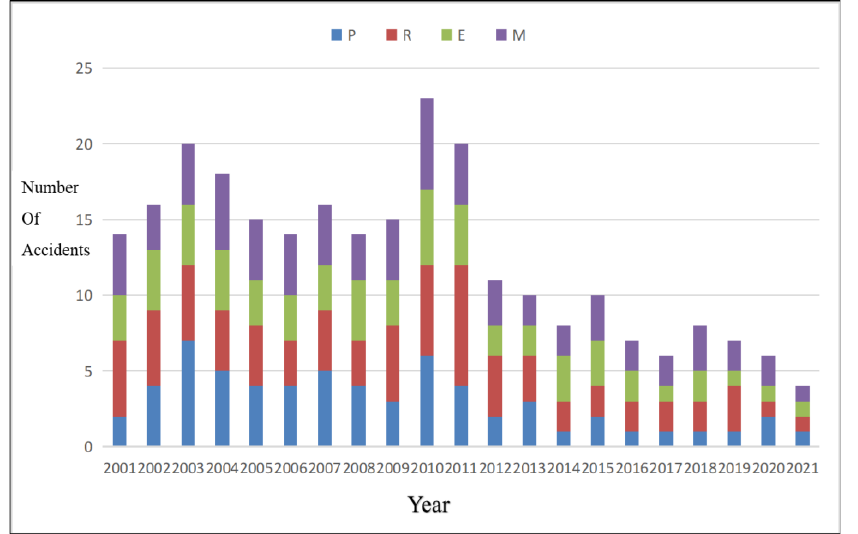
Figure 3. Statistics of autonomous ship accidents caused by corresponding risk factors .